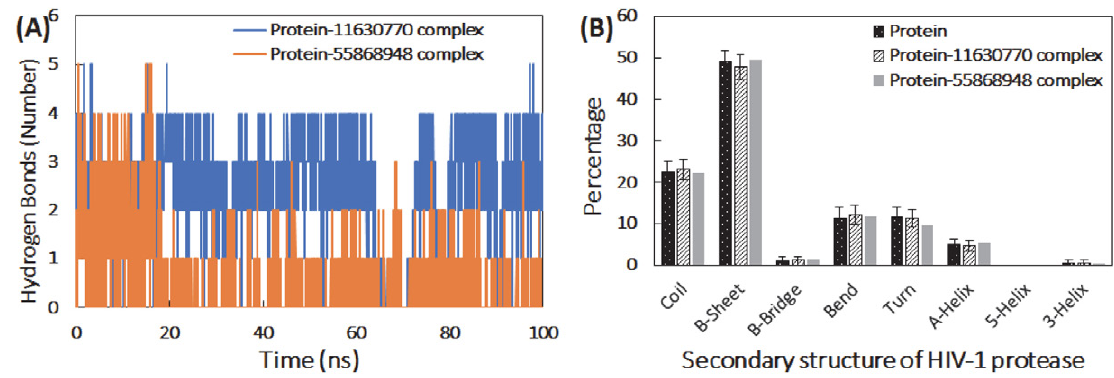
Fig. 10. (A) Number of hydrogen bonds the ligands (11630770 and 55868948) and HIV-1 protease over simulation time. (B) Percentage of second- ary structure in HIV-1 protease in the absence and presence of 11630770 and